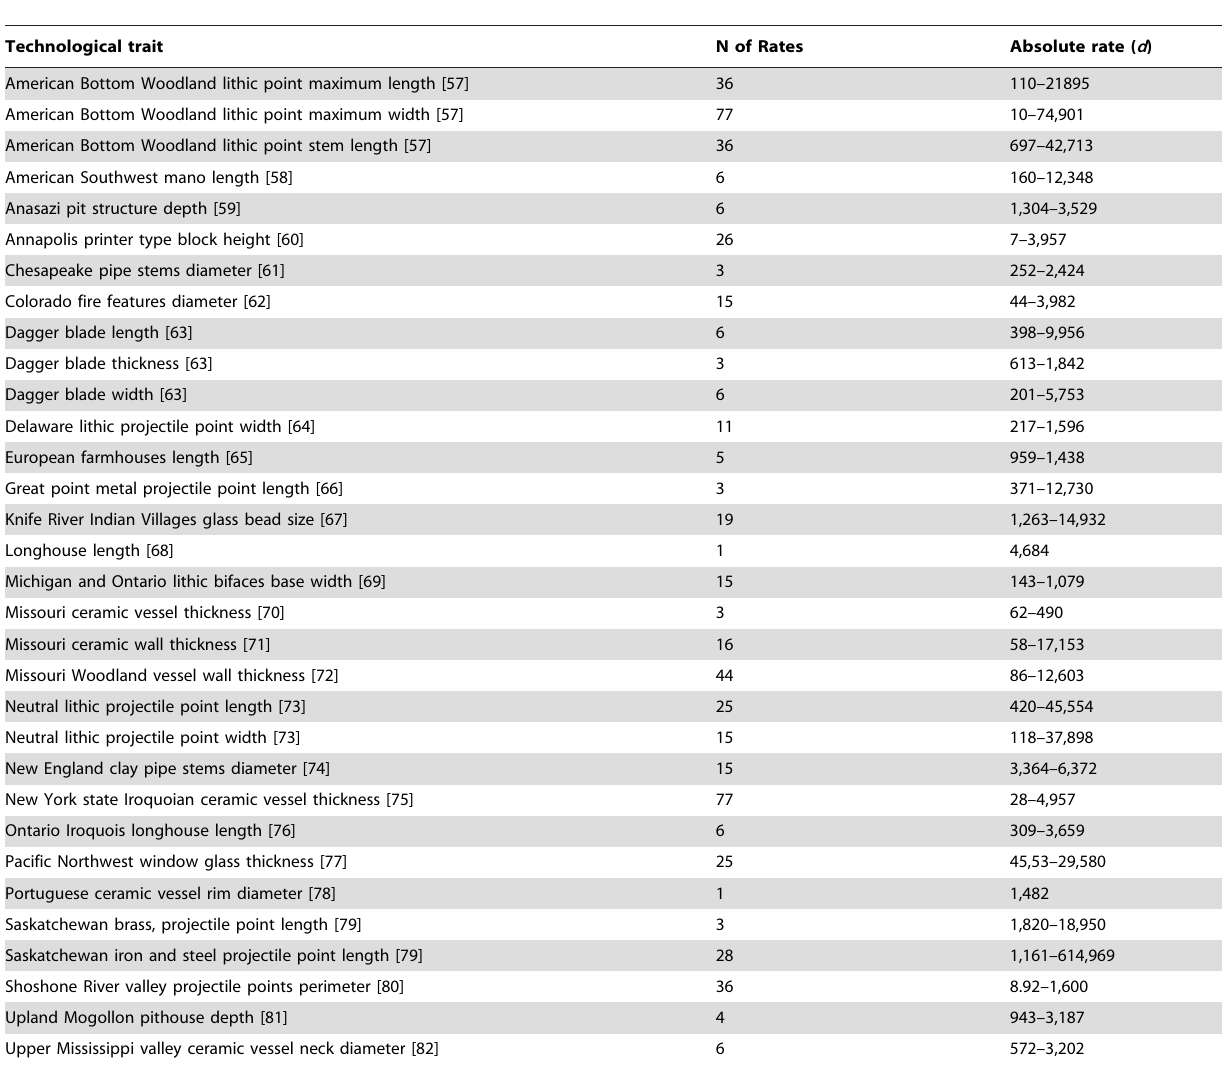
Table 1. Source of the cultural rates from the archaeological record (dataset available upon request.).